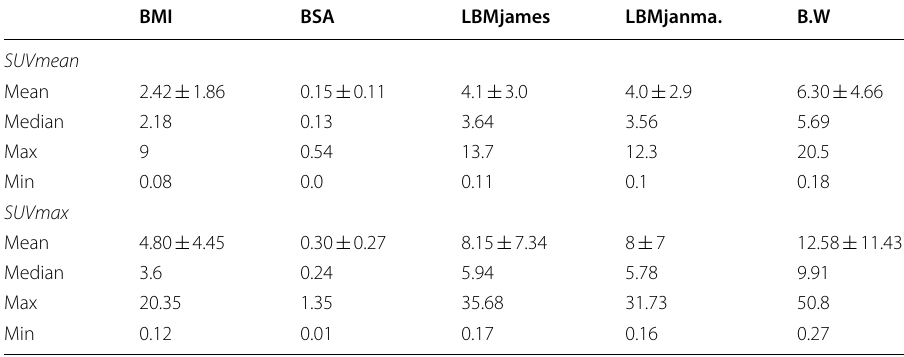
Table 4 Statistical descriptions of lesion normalization with respect to BMI, BSA, LBM, and B.W BMI BSA LBMjames LBMjanma.